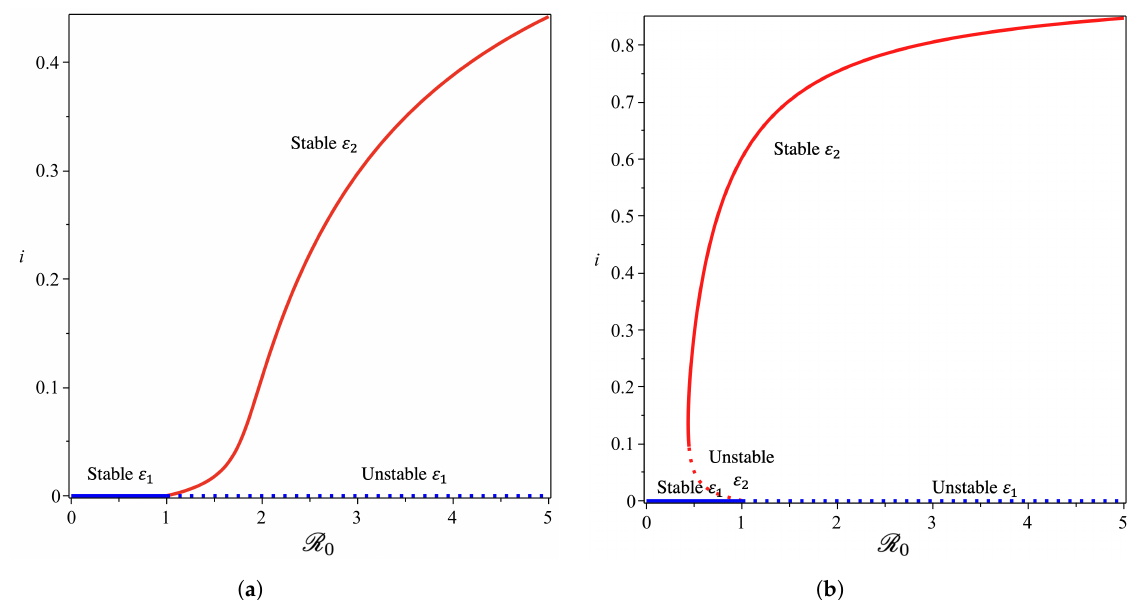
Figure 8. Forward ( a ) and backward ( b ) bifurcation phenomena of the non-dimensionalized malaria model (see Supplementary Section S1, Equation (S4)) from near R 0 = 1 with ω = 25 and ω = 85,